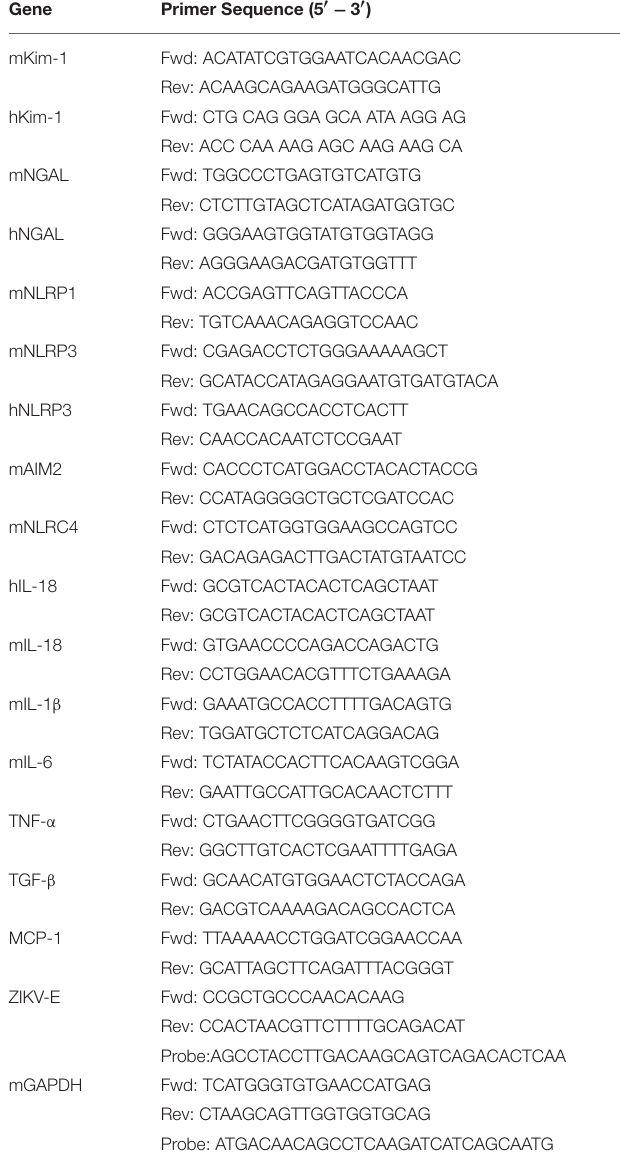
TABLE 1 | Primer sequences for real-time PCR (“m”:mouse; “h”:human; “Fwd”:Forward;